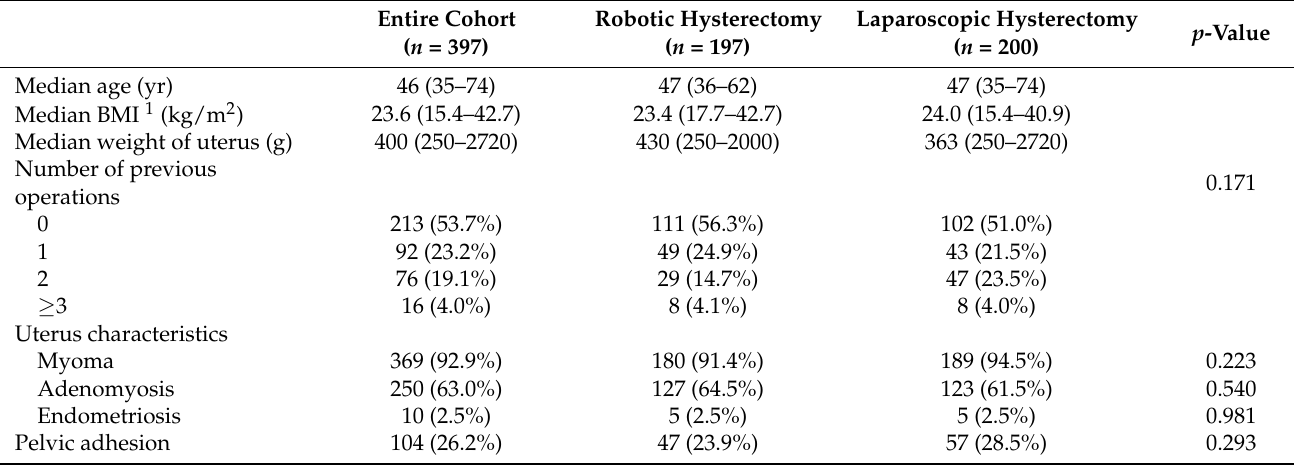
Table 1. The patients’ characteristics by the type of hysterectomy.